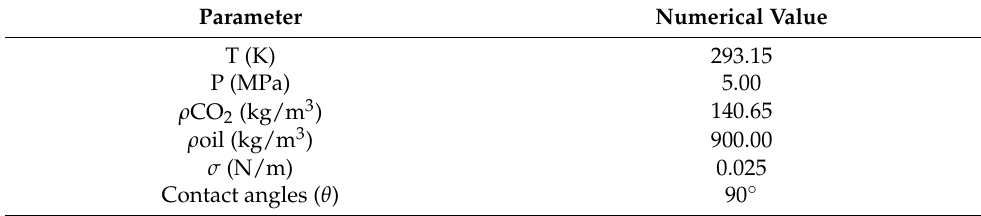
Table 2. Parameters of oil and CO 2